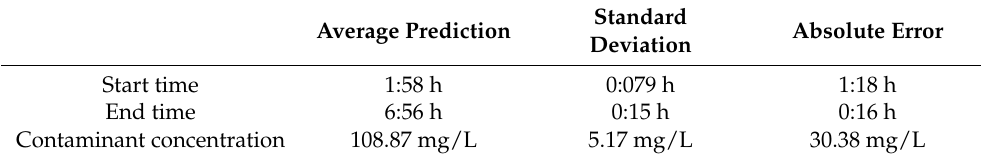
Table 8. NET3 RF regression average values and standard deviations for 100 runs with absolute error.